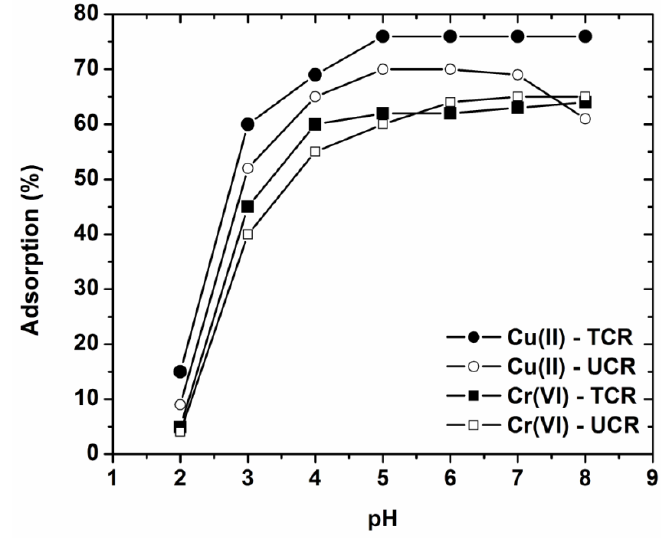
coffee residues (pH = 2–8, 50 mg/L ion concentration, 1 g/L adsorbent, T = 25 °C, 140 rpm, 24 h